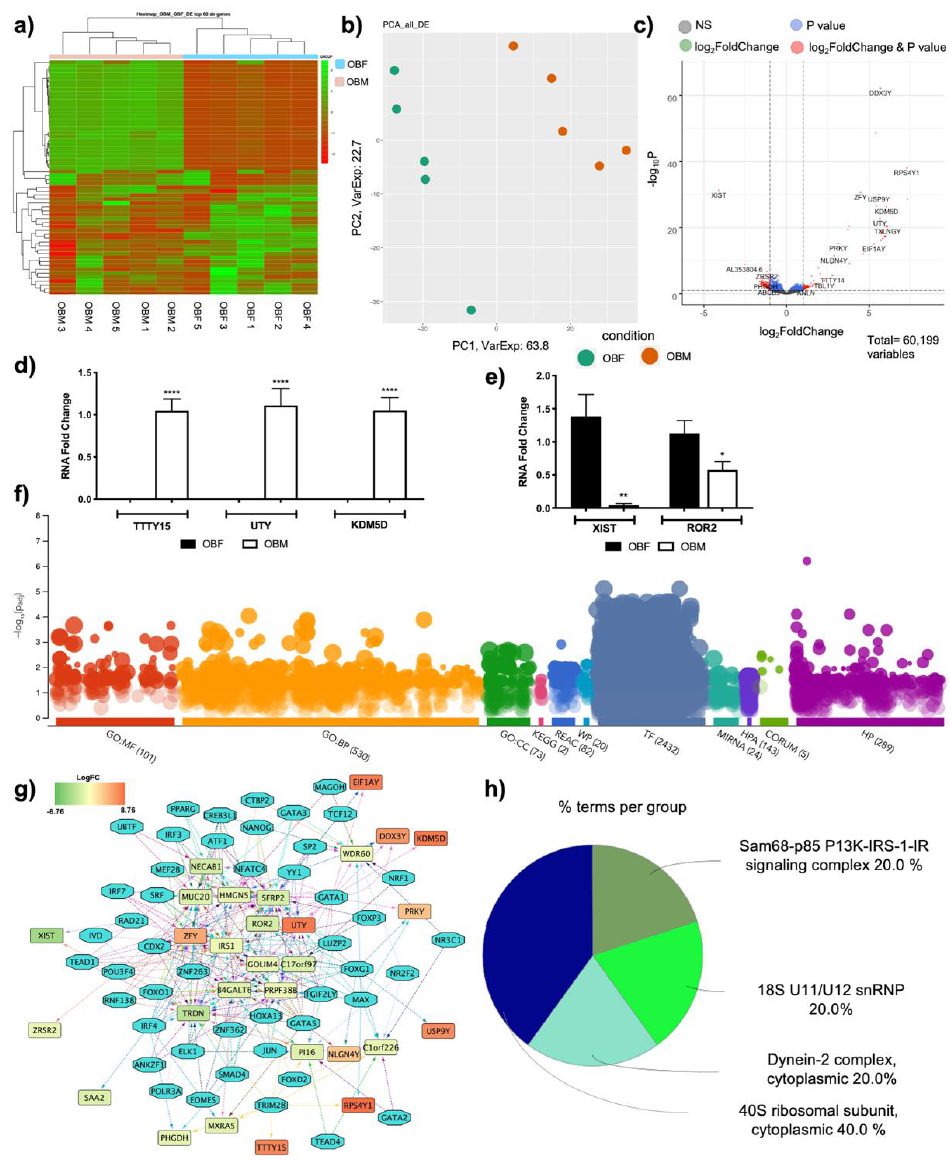
Figure 1. Transcriptome analysis highlights different expression profiles in the SAT of obese men versus women: ( a ) Heatmap analysis of differentially expressed genes (DE RNAs) in obese men (OBM) versus obese women (OBF). ( b ) Principal Component Analysis (PCA) of DE RNAs in OBM versus OBF. ( c ) Volcano plot showing DE RNAs between OBM and OBF. ( d ) mRNA expression levels of genes with a positive fold change were evaluated by Real-Time PCR in 11 OBF vs. 7 OBM. Data are expressed as mean ± SEM. **** p <0.0001 vs. OBF. ( e ) mRNA expression levels of genes with a negative fold change were evaluated by Real-Time PCR in 11 OBF vs. 7 OBM. Data are expressed as mean ± SEM. * p < 0.05, ** p < 0.01 vs. OBF. ( f ) DE RNAs were subjected to functional enrichment